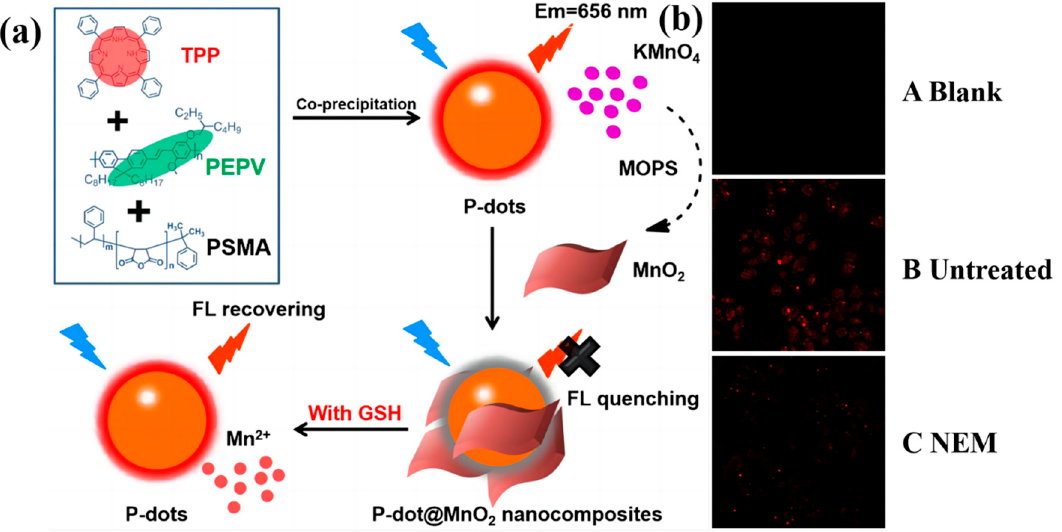
Figure 2. ( a ) Schematic representation of the fabrication of the Pdot@MnO 2 nanocomposite-based sensing platform for GSH detection. Adapted with permission from [44]. ( b ) Fluorescence microscopic images of ( A Blank ) HeLa cells only, ( B Untreated ) HeLa cells treated with Pdot@MnO 2 nanocomposites, and ( C NEM ) HeLa cells treated with NEM, as well as P-dot@MnO 2 nanocomposites. Adapted with permission from [44].